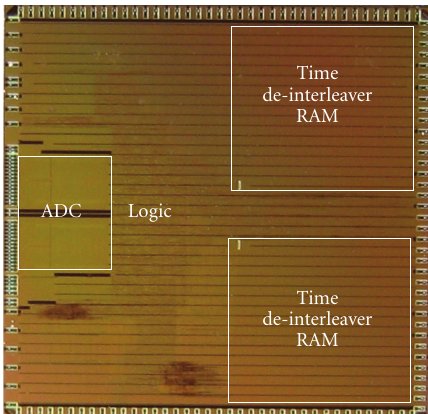
Figure 15: Die micrograph.